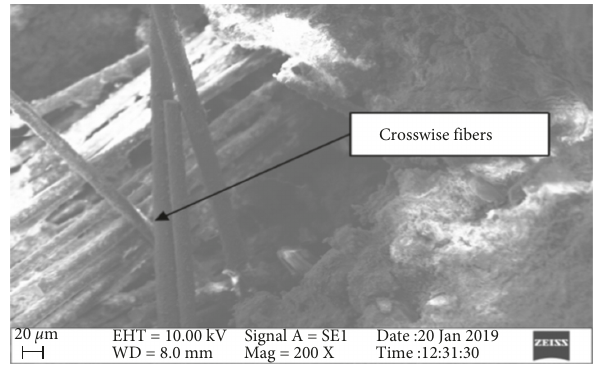
Figure 25: Combination of basalt fiber and cement